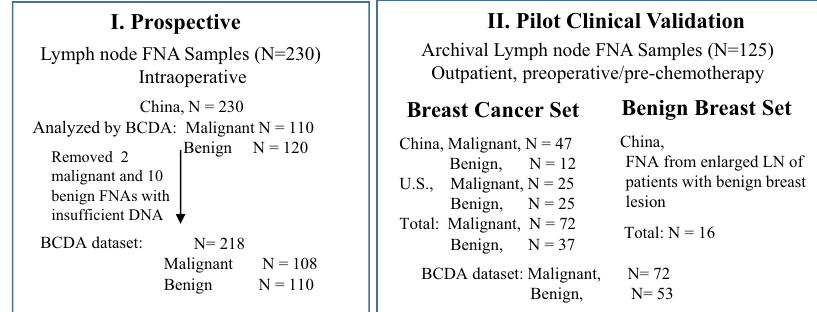
Fig. 1 Study work fl ow and sample selection. Two studies were conducted sequentially, I The prospective study was conducted on patients with breast cancer undergoing SLNB. LN-FNA was collected, after excision, from one selected, enlarged sentinel node for cytology and BCDA. Histological diagnosis of the same LN served as a gold standard. II A pilot clinical validation on archival FNA. BCDA was performed on archival LN-FNA samples, selected by the cytologists. FNA was collected from an enlarged ipsilateral axillary lymph node in women with breast cancer (Breast Cancer Set) or a benign breast lesion (Benign Breast Set). Lymph nodes were aspirated for cytology in the outpatient center; in cancer patients, this occurred preoperatively or prior to initiation of neoadjuvant chemotherapy. Samples from both studies were de-identi fi ed and blinded to the lab personnel. FNA fi ne needle aspirate. Total FNA samples: Intraoperative prospective blinded study of N = 230, evaluable FNA samples: N = 218. By histopathology: Malignant, N = 108, Benign, N = 110; Pilot clinical validation study: N = 125. By cytology, Malignant, N = 72, Benign, N = 53. In the group of benign LNs, 37 LN-FNAs were from women with breast cancer, and 16 LN-FNAs were from women with benign breast disease. Table 1. Patient characteristics in the prospective